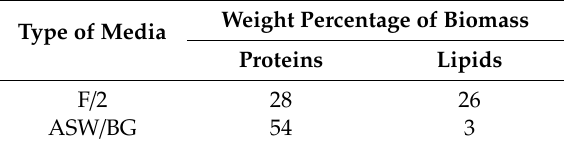
Table 2. Accumulation of proteins and lipids in Synechococcus grown in F / 2 and ASW / BG